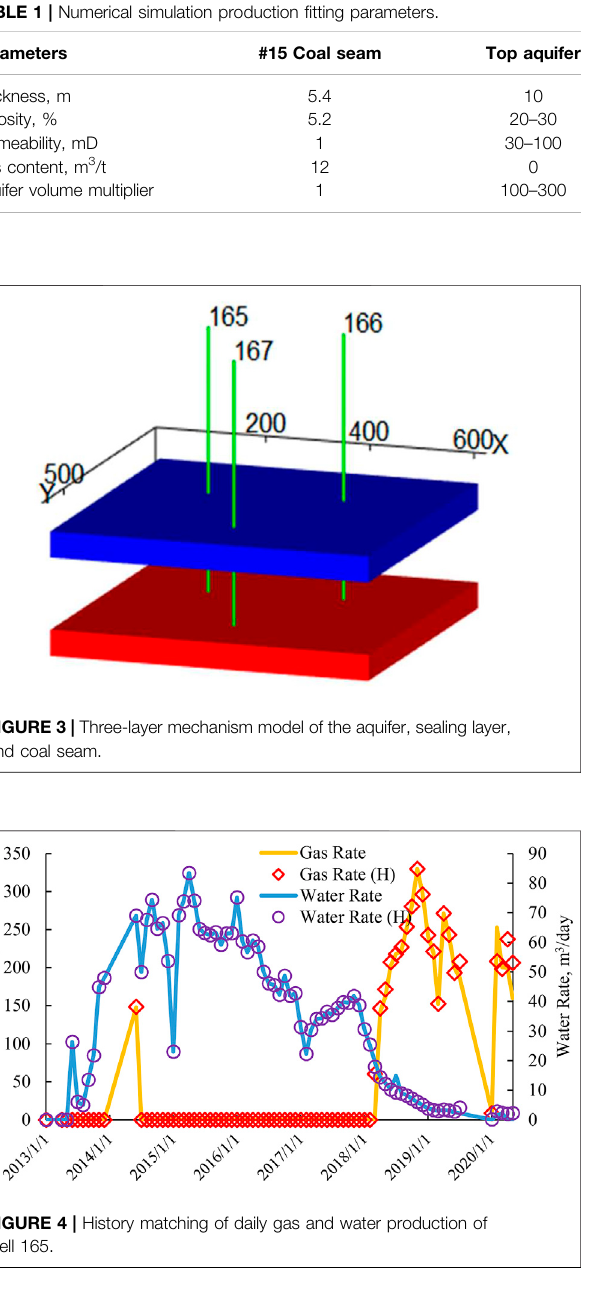
seam with the top water layer established in this study, the in fl uence of the top water layer on the production status of the CBM well was quanti fi ed by applying numerical simulation techniques. As shown in Table 1 , the values of coalbed parameters are taken to be the same as the actual situation, and the maximum and minimum values of